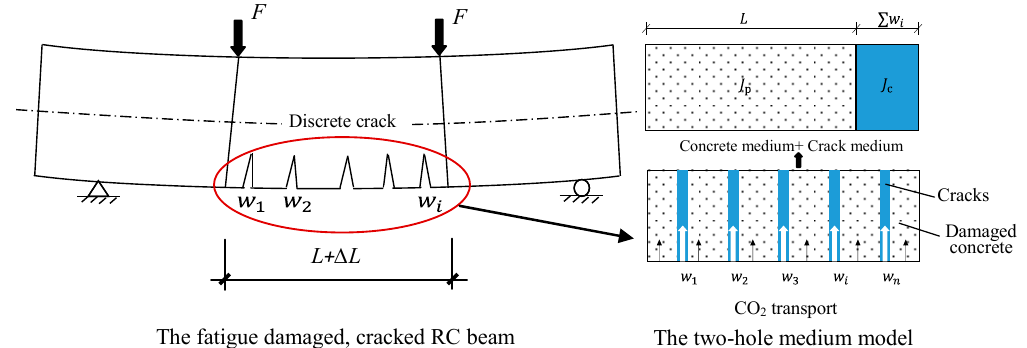
Figure 13. The model on the carbon dioxide transport process in damaged, cracked RC beams.